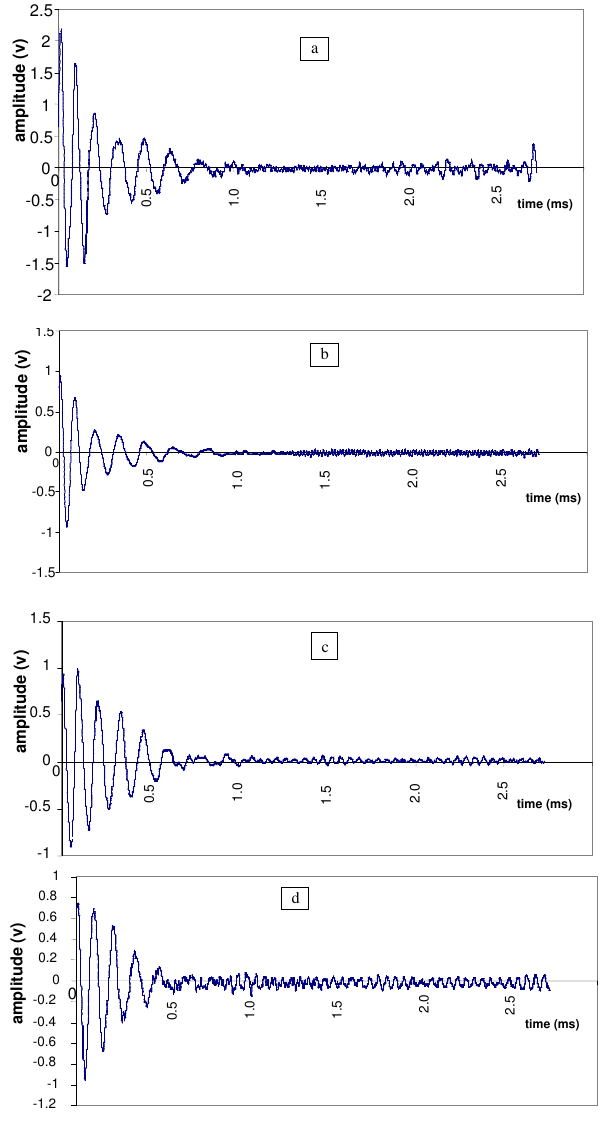
Fig. 2. Electric fields of sferics registered in September, Electric fields of sferics registered in September, 2006.